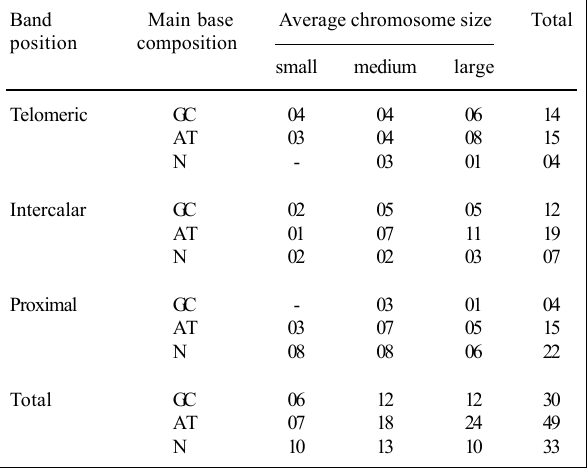
Table IV - Distribution of C-bands with different base composition in karyotypes of small, medium and large chromosomes (based on Table I). Band Main